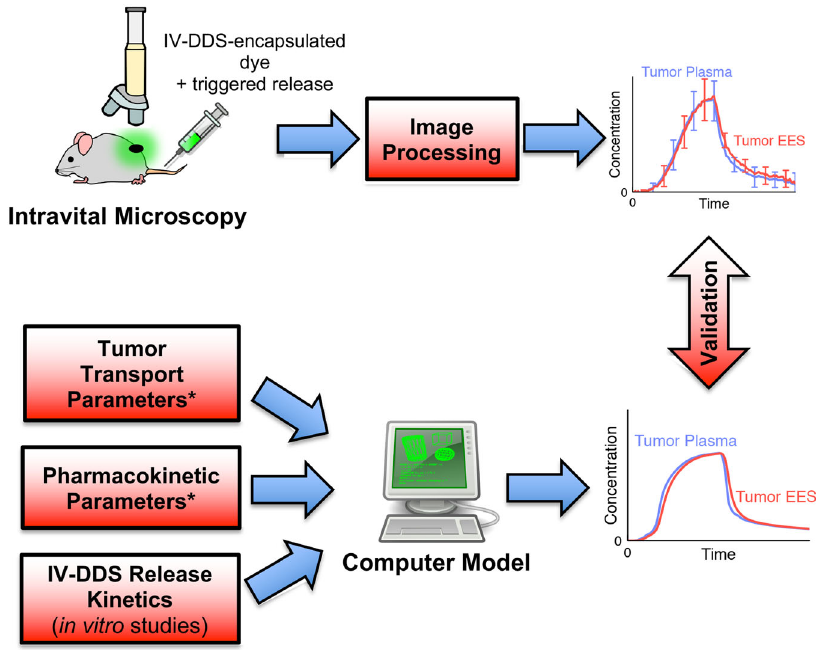
Fig. 7 Validation of IV-DDS computer model by quantitative intravital microscopy. A computer model was developed to simulate delivery kinetics of IV- DDS. The model was validated by quantitative intravital microscopy studies where fl uorescent dye encapsulated in thermosensitive liposomes (TSL) served as example IV-DDS. The computer model was based on in vitro measured IV-DDS (i.e., TSL) release kinetics, and on in vivo measured parameters from the in vivo studies with free dye (parameters marked by asterisks (*), see Fig. 6). The computer model predicted intra- and